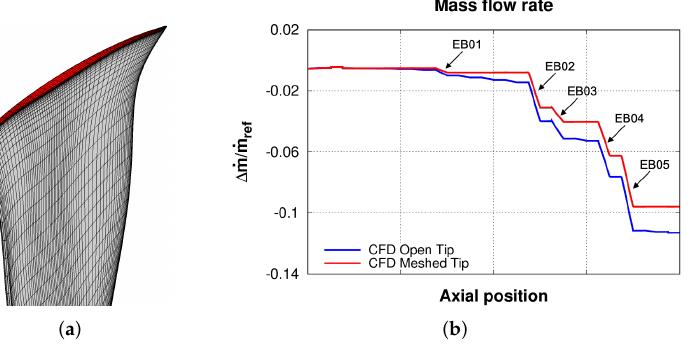
Figure 2. View of the rotor tip gap grid block ( a ) and mass flow rate distribution for the compressor, with and without the meshed tip rotor ( b ) (the axial position of the exit bleeds (EB) is